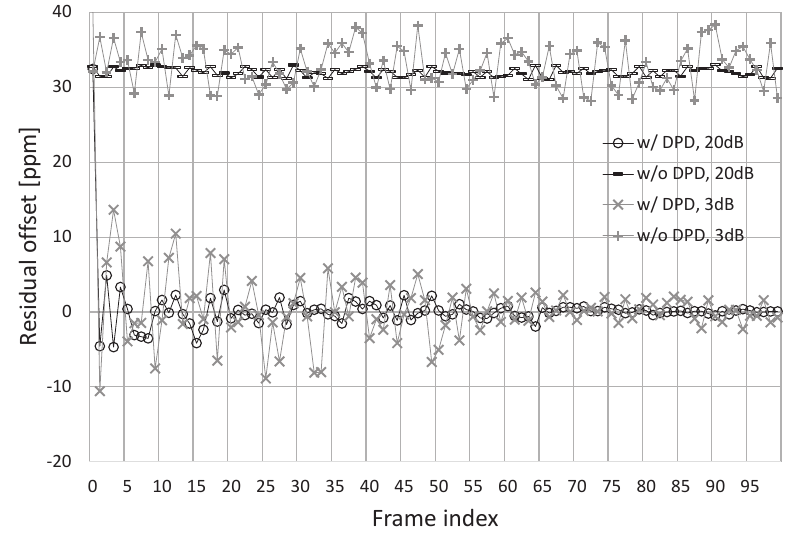
Figure 4. packet error ratio (PER) over CFOs; digital CFO predistortion scheme vs. conventional design.